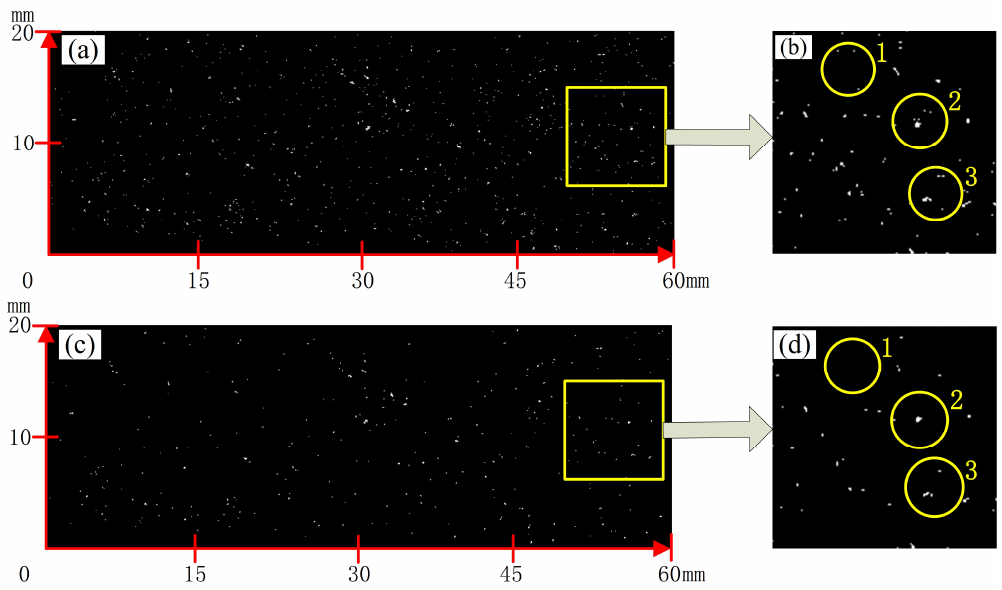
Figure 8. Comparison images before and after morphological process. ( a ) original ultrasonic detection images; ( b ) partial enlarged view of ( a ); ( c ) ultrasonic images after morphological opening operation; and ( d ) partial enlarged view of ( c ).